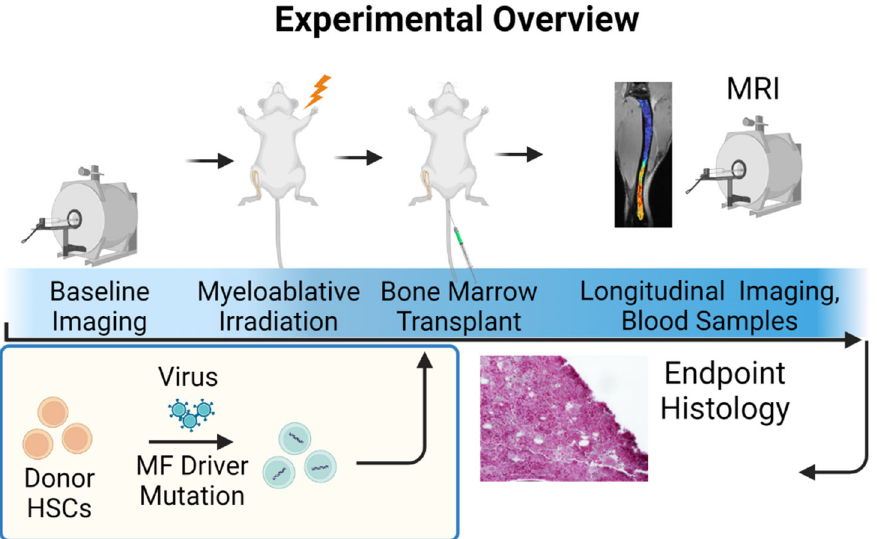
Figure 7. Bone marrow transplant model for myelofibrosis in mice. Baseline spleen and bone marrow MRI data are obtained prior to transplantation. To generate mice with myelofibrosis (MF), normal donor hematopoietic stem and progenitor cells (HSCs) are transduced with a known driver mutation. Transduced HSCs are transplanted into recipient mice after myeloablative irradiation, using bone marrow MRI and spleen volume to quantify disease progression and response to therapy. The same MRI methods are used for clinical studies in patients with MF.